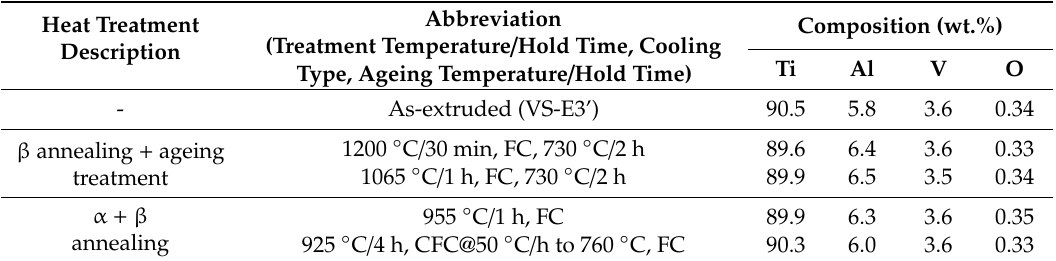
Table 2. A summary of chemical composition and oxygen contents of the extruded Ti-6Al-4V rods after various heat